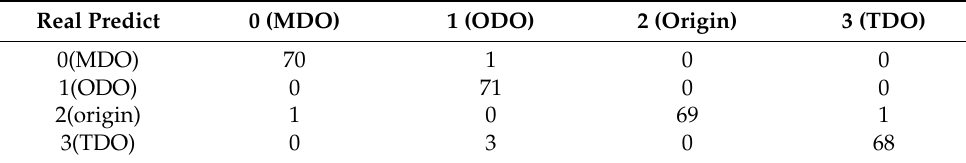
Table 5. Confusion matrix. Real